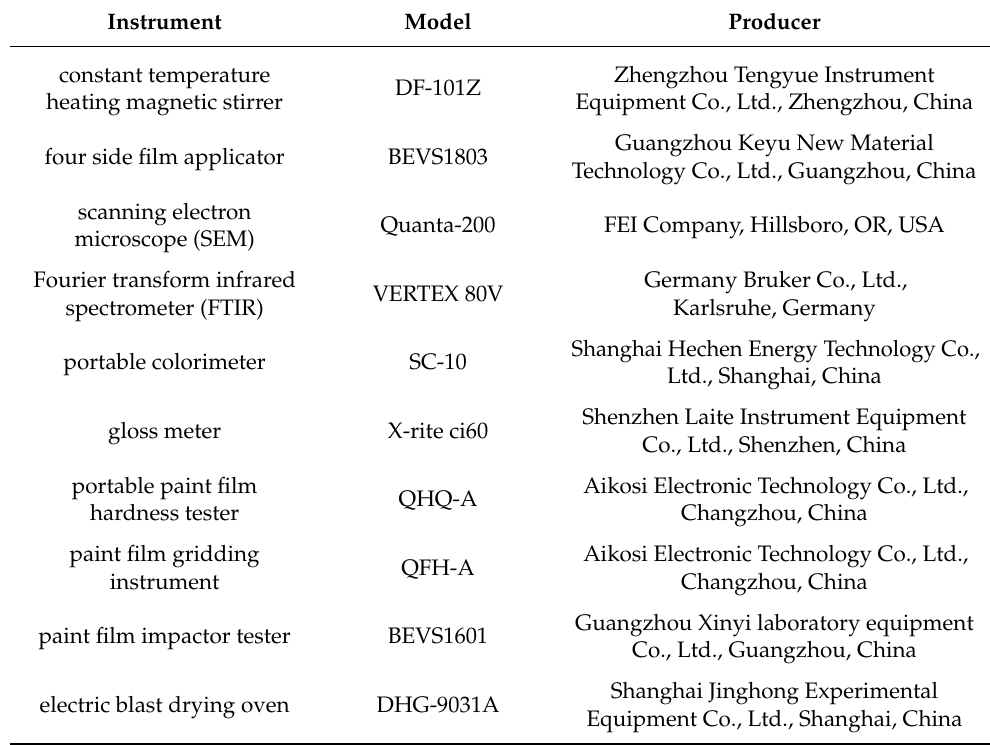
Table 3. Experimental instrument